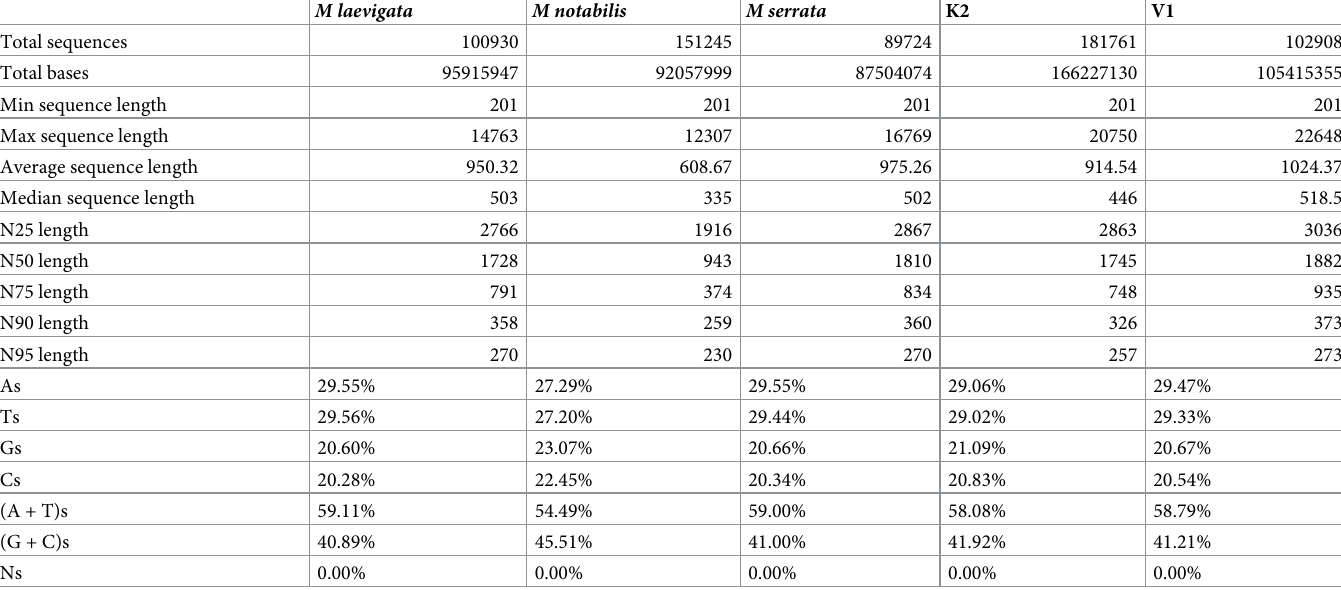
Table 1. Showing the different stats of Trinity assemblies of different species and two